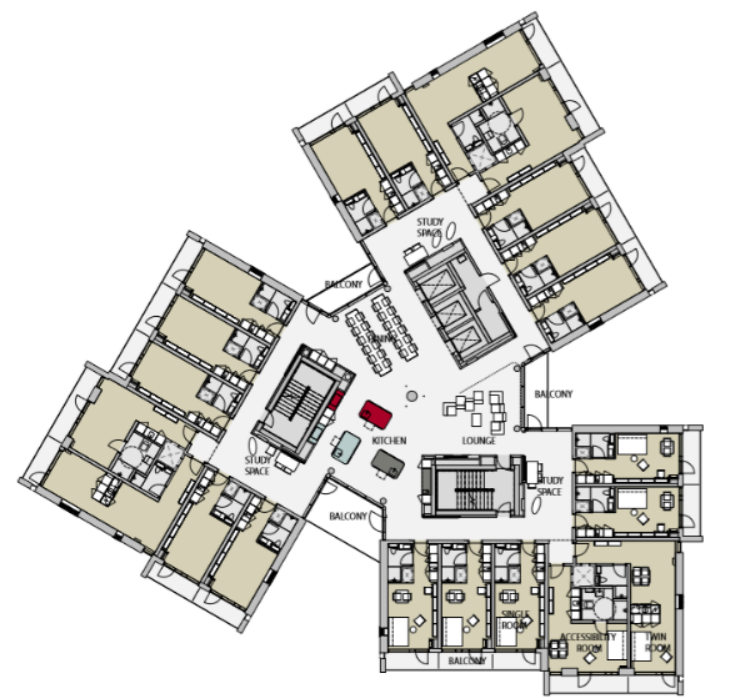
Figure 4. Horizontal social spaces. Floor plan of the Campus College’s sixth floor. At Campus College, every floor has a shared kitchen and living room located in the distribution area next to the elevator in the core of the three residential areas with a total of 21 units. Source: Mechlenborg and Hauxner (2021, p. 45), with the courtesy of C. F. Møller Architects. House, or the bar facilities at Nordbro, Copenhagen (Figure 5).